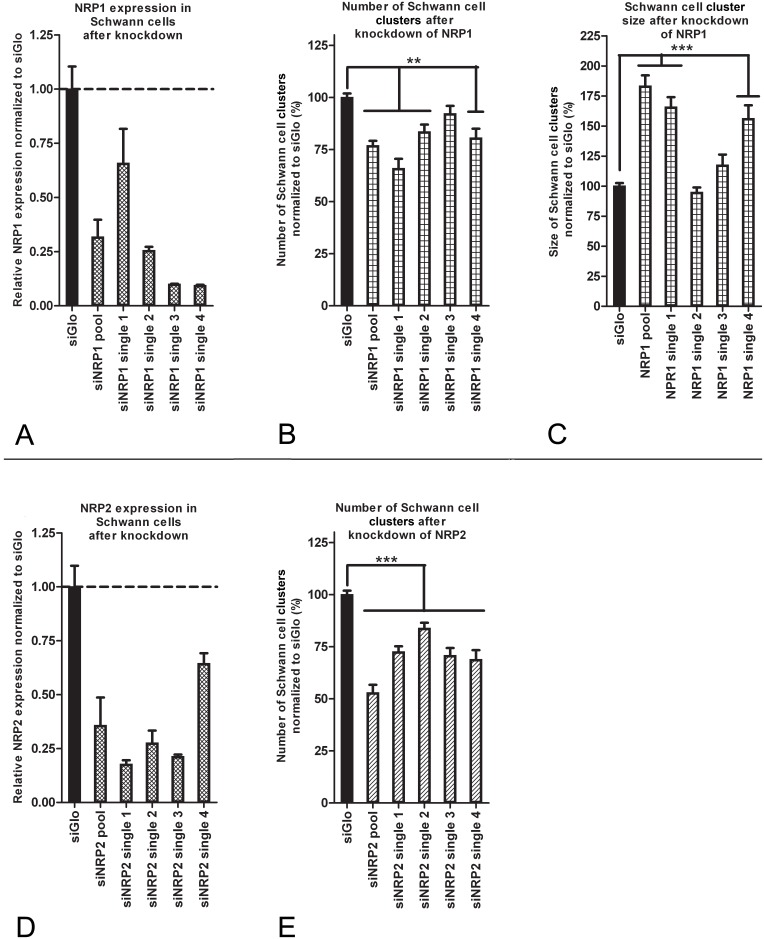
Validation of NRP1 and NRP2 knockdown effects on SC cluster formation.(A) mRNA levels of NRP1 were decreased in SCs after transfection with the siRNA pool or either of the 4 single siRNAs. Expression levels were ranging from 9 to 66% of endogenous expression measured in the siGlo condition. Knockdown was significant for all conditions (p<0.001) except for siNRP1 single 1 (p<0.12). The value presented for the siNRP1 pool is the result of 4 different experiments. The values for the siNRP1 singles are the result of 1 experiment with 4 technical replicates. The siGlo condition presented in the graph is the control for the single siRNA conditions. (B) Three single siRNAs confirm the significant decrease in the number of clusters which is observed with the siNRP1 pool (p<0.01). (C) Two of the single siRNAs confirm the increase of cluster size observed with the siNRP1 pool (p<0.001). All values are normalized to the siGlo condition. The presented values represent the average of 3 separate experiments. The differential effects of siNRP1 single 2 and 3 may be the result of off-target effects (D) mRNA levels of NRP2 were decreased in SCs after transfection with the siRNA pool or either of the 4 single siRNAs. Expression levels were ranging from 18 to 64% of endogenous expression measured in the siGlo condition. Knockdown was significant for all conditions (p<0.05). The value presented for the siNRP2 pool is the result of 4 different experiments. The values for the siNRP1 singles are the result of 1 experiment with 4 technical replicates. The siGlo condition presented in the graph is the control for the single siRNA conditions. (E) All 4 single siRNAs confirm the significant decrease in the number of clusters which is observed with the siNRP2 pool (p<0.01). The presented values represent the average of 3 separate experiments. Error bars indicate the SEM.